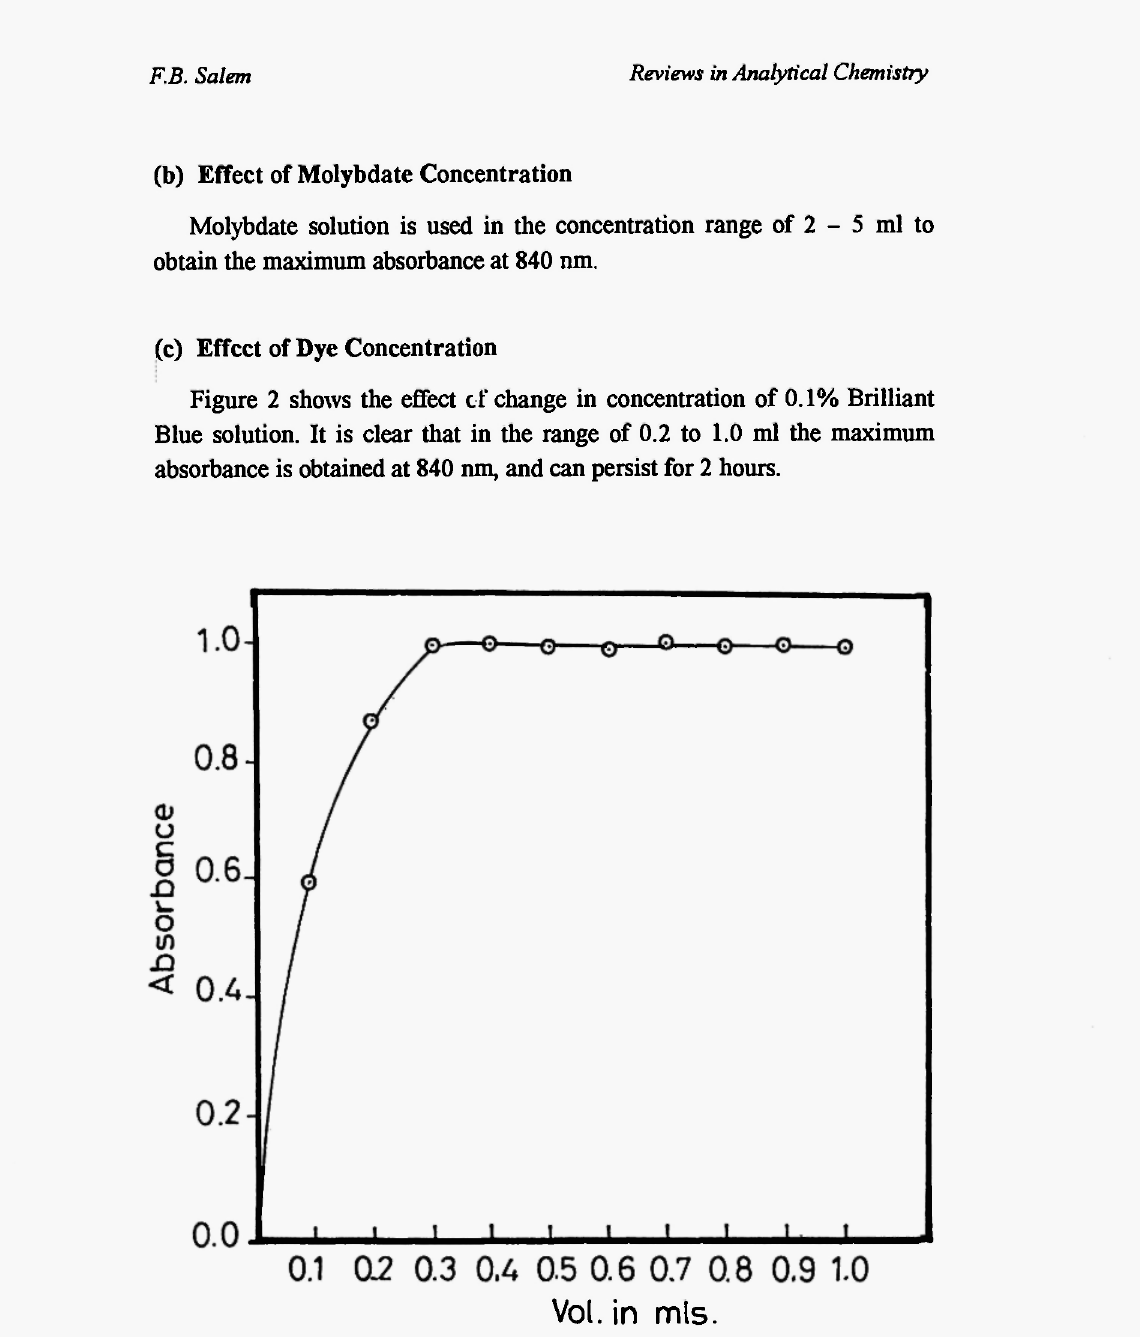
Fig.(2): Effect of the volumes of Brilliant